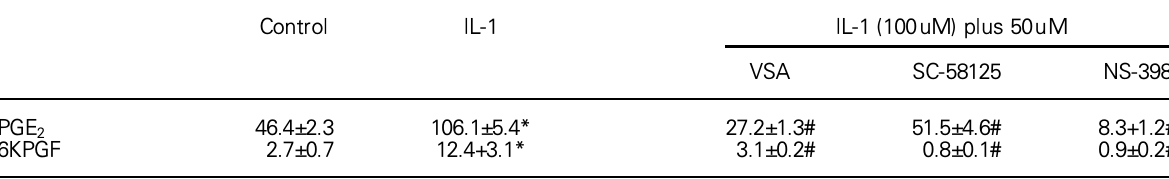
Table 2. The effect of cyclooxygenase 1 and 2 inhibitors on IL-1 b stimulated prostaglandin E2 and prostacyclin (6-keto PGF 1 formation (ng/mg cell protein) by human intestinal smooth muscle cells